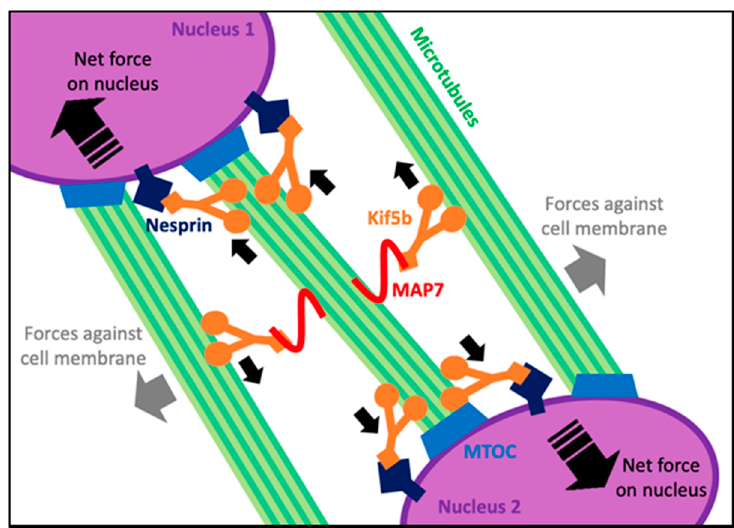
Figure 3. A summary of the microtubule-dependent forces on nuclei when they spread in maturing myofibers. Small solid black arrows show the direction of movement of each Kif5b motor along microtubules. Large dashed black arrows within nuclei show the net force and direction of movement of the corresponding nucleus.